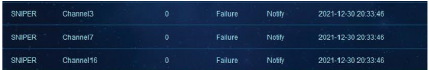
Figure 13: Screenshot of failure prediction result logs.